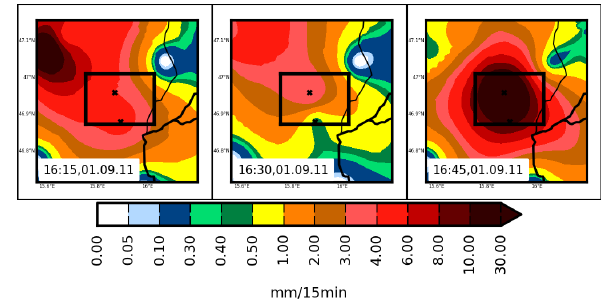
Figure 9. Spatio-temporal distribution of 15min interpolated TAWES station measurements (mm/15min) on 1 September 2011 between 16:15 and 16:45UTC (region of WegenerNet is shown by the black rectangle and the two TAWES stations of ZAMG are marked with a